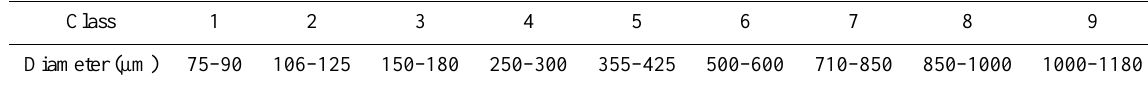
Table 1. Classes of particle diameters used for the experiments.